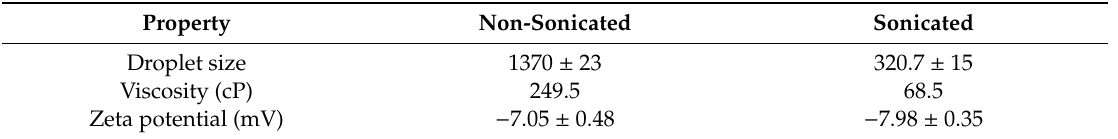
Table 4. Properties of non-sonicated and sonicated emulsions with 60% w / w SEDDS as dispersed phase in deionized water (mean ± SD).